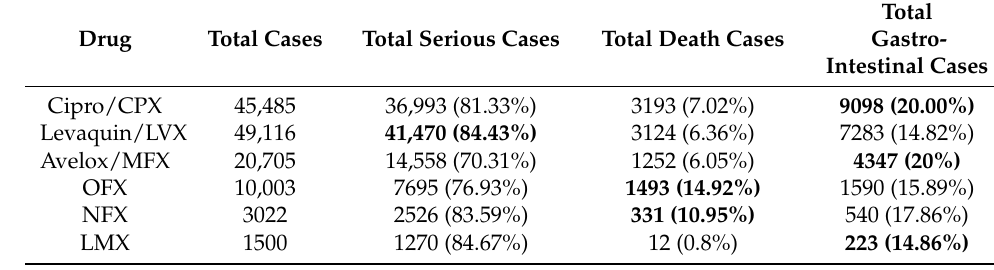
Table 1. Summary of the total number of adverse reactions, serious cases, death cases, and total gastrointestinal (GI) cases for the six FQs analyzed in the present study. Bolded values indicate the possibility of a relationship between a drug and an adverse drug reaction as analyzed through chi-square analysis. CPX, ciprofloxacin; LVX, levofloxacin; MFX, moxifloxacin; NFX, norfloxacin; OFX, ofloxacin; LMX,